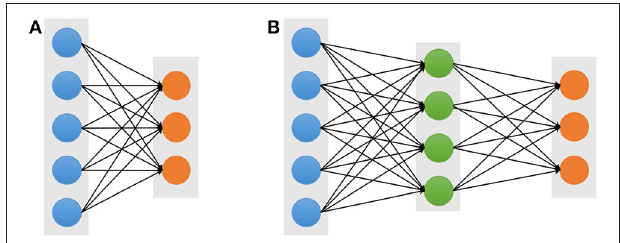
FIGURE 1 | Architectures of the single-layer (A) and multi-layer (B) neural networks. The blue, green, and orange solid circles represent the input visible, hidden, and output units,